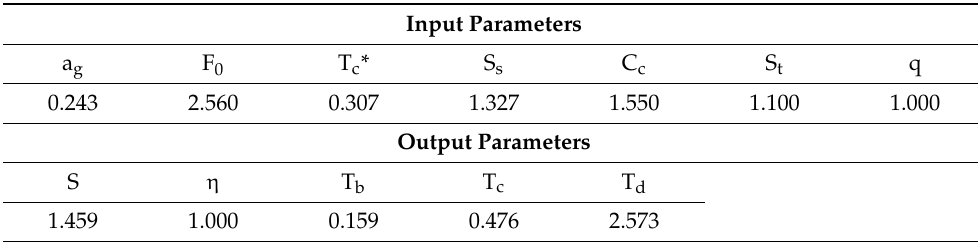
Table 2. Implemented parameters for the national spectrum in the design code. Benchmarks of the Terenzo site (ULS, Vr = 200 years, Soil type C, topography T 2 ).